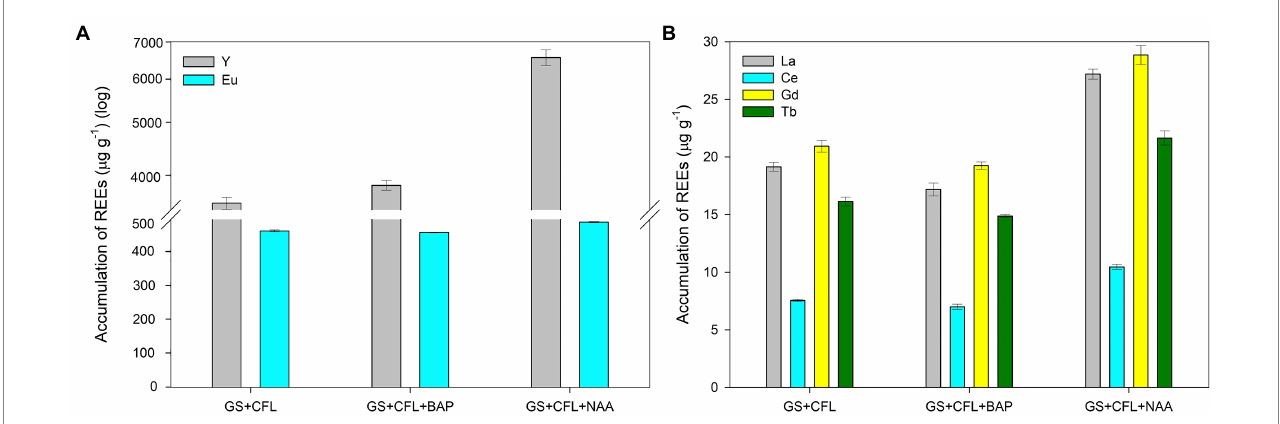
FIGURE 7 Effect of plant hormones NAA and BAP on the accumulation of individual REEs in Galdieria sulphuraria under CFL treatment. (A) Y and Eu accumulation following NAA and BAP treatments, and (B) La, Ce, Gd and Tb accumulation under NAA and BAP treatments. Expressed as concentrations in μ g g − 1 . The error bars represent standard deviations (±SD). For details of statistical analysis (one-way ANOVA, Tukey’s HSD) see Supplementary Table